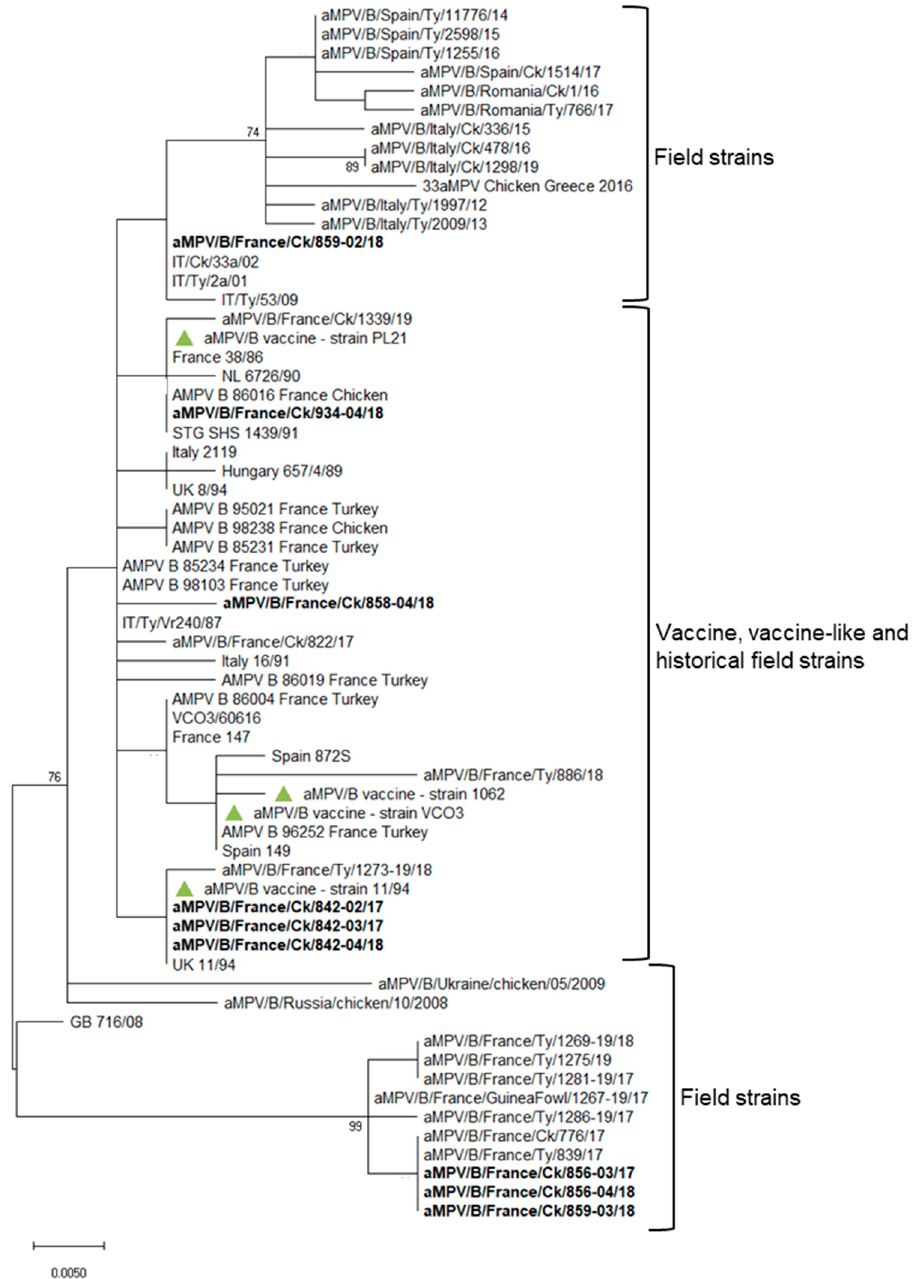
Figure 2. Phylogenetic tree based on G gene nucleotide sequences of French aMPV-B strains. The analysis included B strains detected in broiler longitudinal studies (shown in bold), historical French B field strains, contemporary selected European B strains [13] and B vaccines most commonly used (marked with a green triangle). The evolutionary history was inferred using the maximum likelihood method and Kimura 2-parameter model implemented in MEGA X. All nucleotide positions containing gaps and missing data were eliminated. There were a total of 288 positions in the final dataset. Only bootstrap values ≥ 70% are reported.